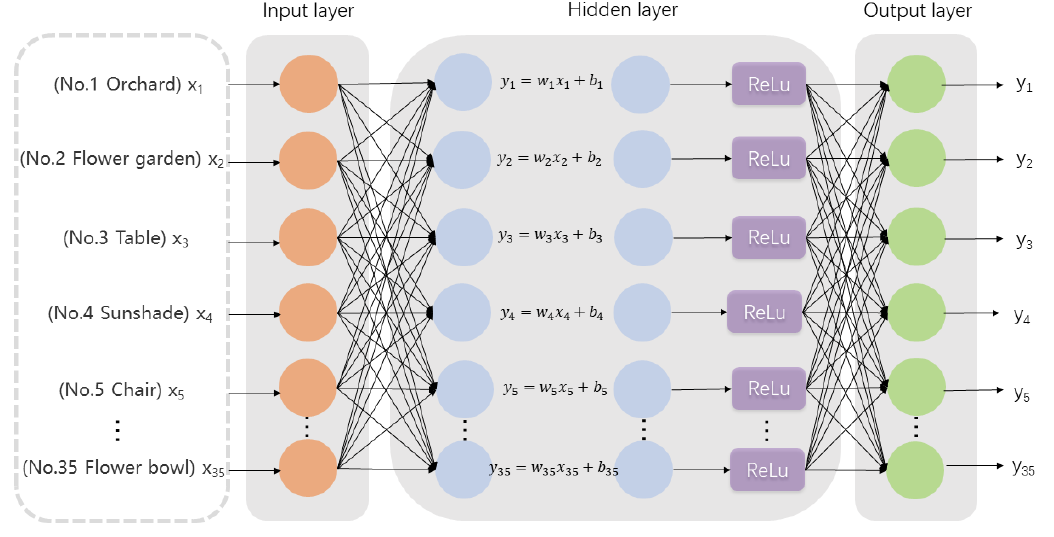
Figure 2. The BP network model.